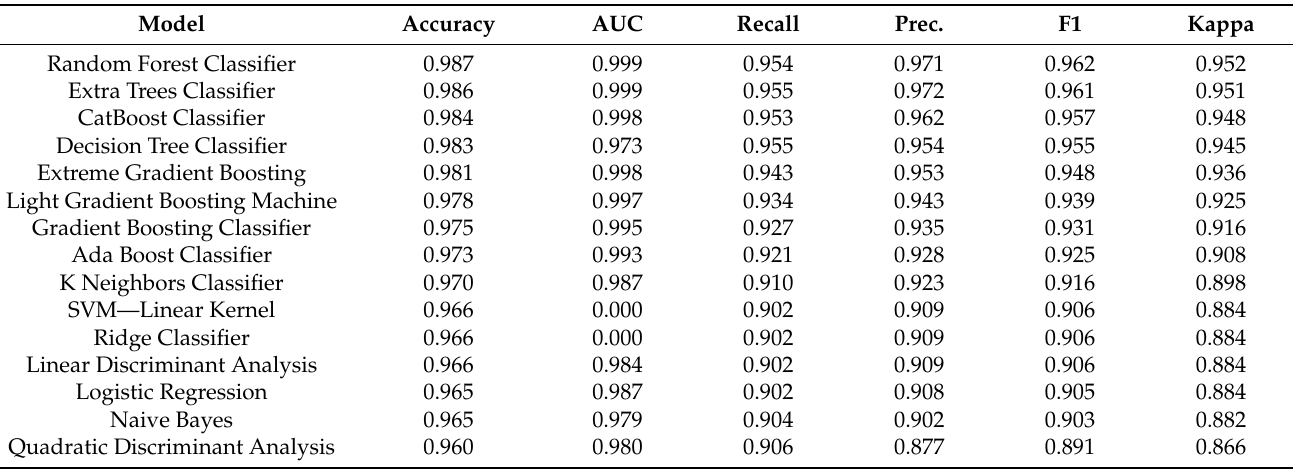
Table A1. Classification metrics for the Pure